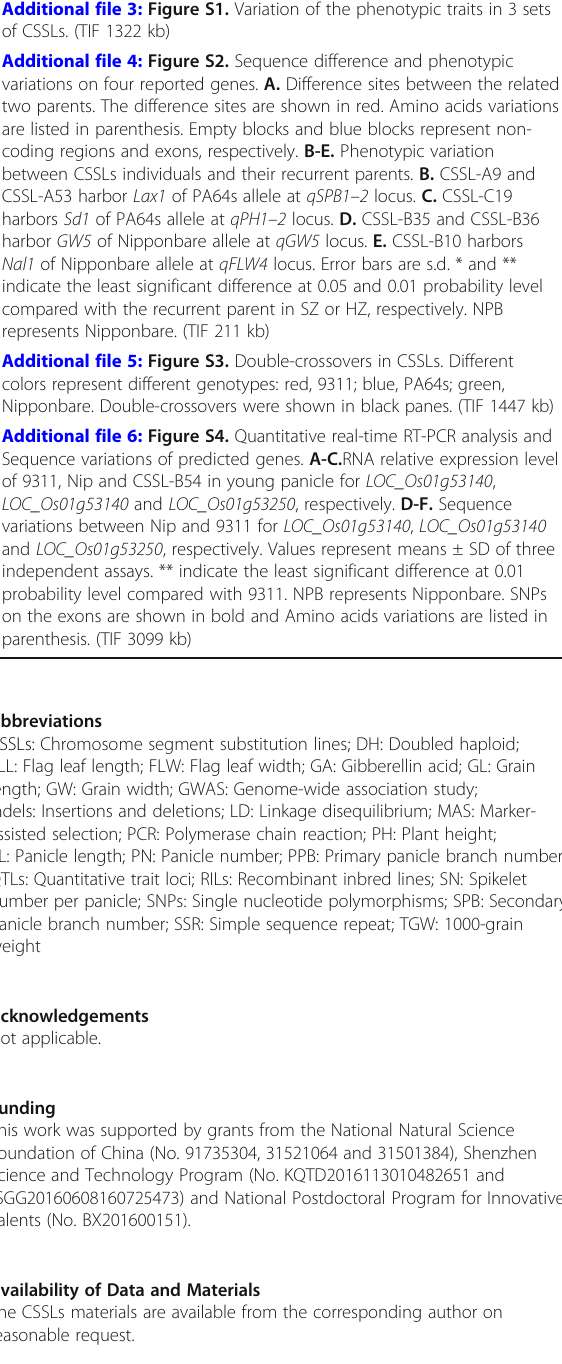
Table S7. Correlation analysis of 11 traits for C set CSSLs in Shenzhen (SZ). P values are shown below and bolds mean P < 0.01. Table S8. Candidate genes in the 119 kb interval for qGL1 . Bolds indicate differential expressed genes based on RNA-seq data. Table S9. Primers used for se- quence identification. (DOCX 45 kb) Additional file 3: Figure S1. Variation of the phenotypic traits in 3 sets of CSSLs. (TIF 1322 kb)